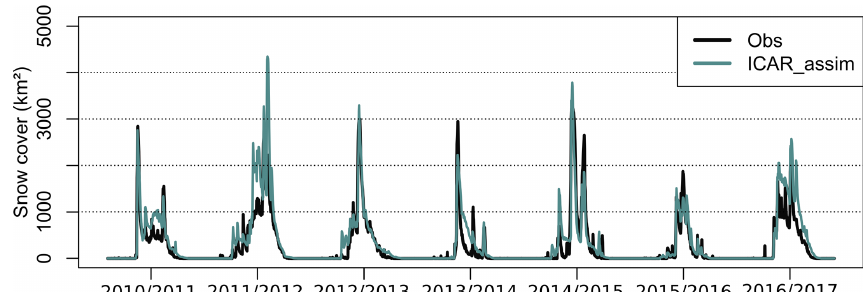
Figure 6. Daily snow cover extent comparison between MODIS gap-filled products and ICAR_assim.